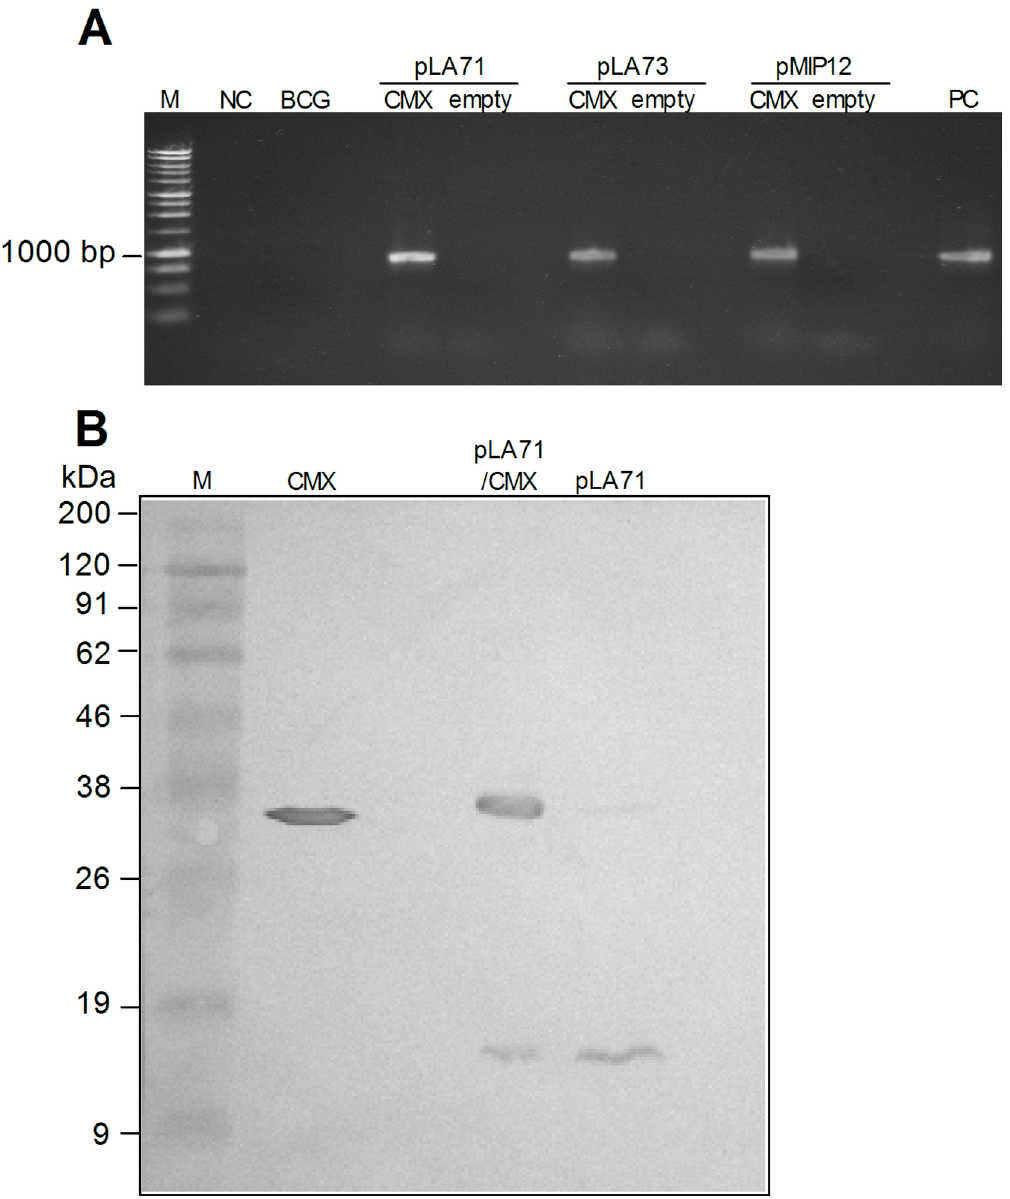
Figure 1. Plasmid construction and CMX expression for three different rBCG-CMX vaccines. (A) PCR products corresponding to the CMX fusion gene, CMX ( , 860 bp), from all three plasmid constructions and their respective empty controls: pLA71, pLA73 and pMIP12. M: molecular weight marker; NC: negative control reaction, using water; BCG: DNA from BCG-Moreau; rBCG transformed with pLA71, pLA73 and pMIP12, with (CMX) or without (empty) the fusion gene; PC: positive control reaction. (B) Analysis of CMX expression in rBCG-pLA71/CMX. Western blot of BCG transformants containing pLA71/CMX or empty vector using polyclonal antibody produced against rCMX. M: molecular mass marker; CMX: purified recombinant CMX; pLA71/CMX: rBCG with plasmid pLA71/CMX; pLA71: rBCG with plasmid